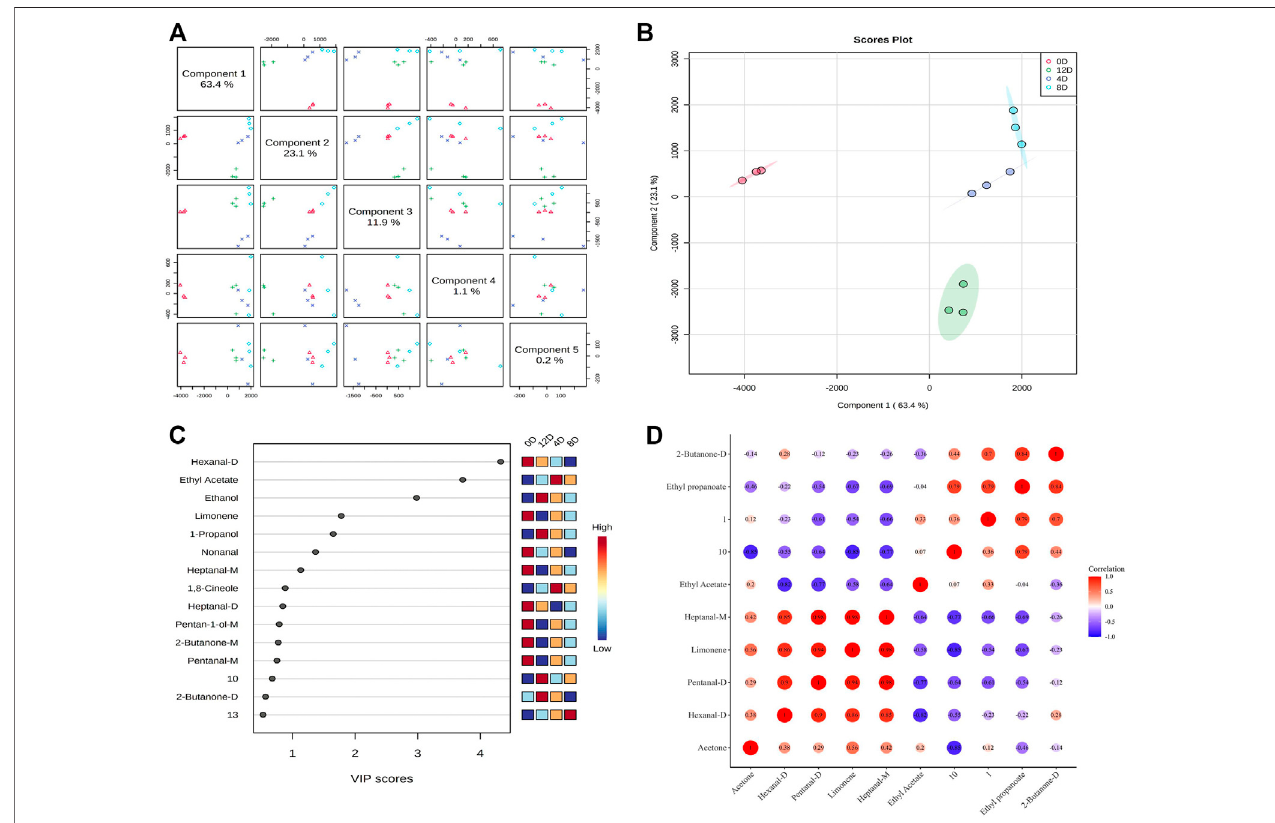
FIGURE6| Overviewofscoreplots. (A) andtwo-dimensionalscoreplots. (B) offermentedmandarin fi shsamplesbasedonpartialminimumdiscriminantanalysis. Important features of mandarin fi sh during fermentation identi fi ed by partial minimum discriminant analysis. (C) Colored boxes on the right indicate the relative concentrations of the corresponding metabolites in each evaluated group. Correlation map of volatile metabolites (VIP > 1) subjected to fermentation. (D) Values are obtained from three biological replicates.